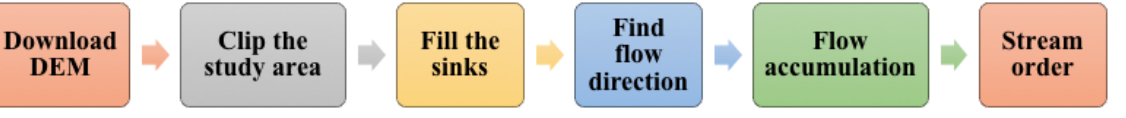
Figure 6. Key steps used to extract the stream order from DEM.